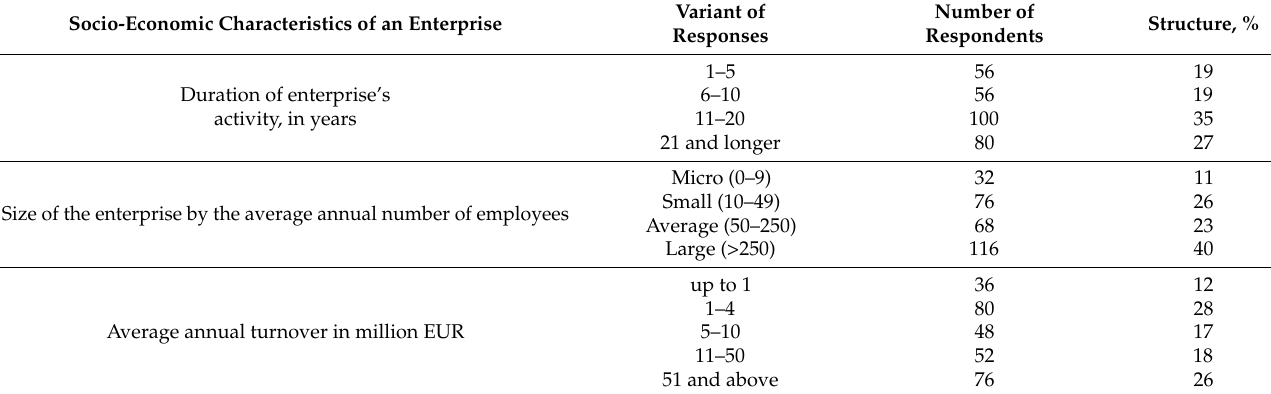
Table 2. Socio-economic characteristics of respondents ( n =